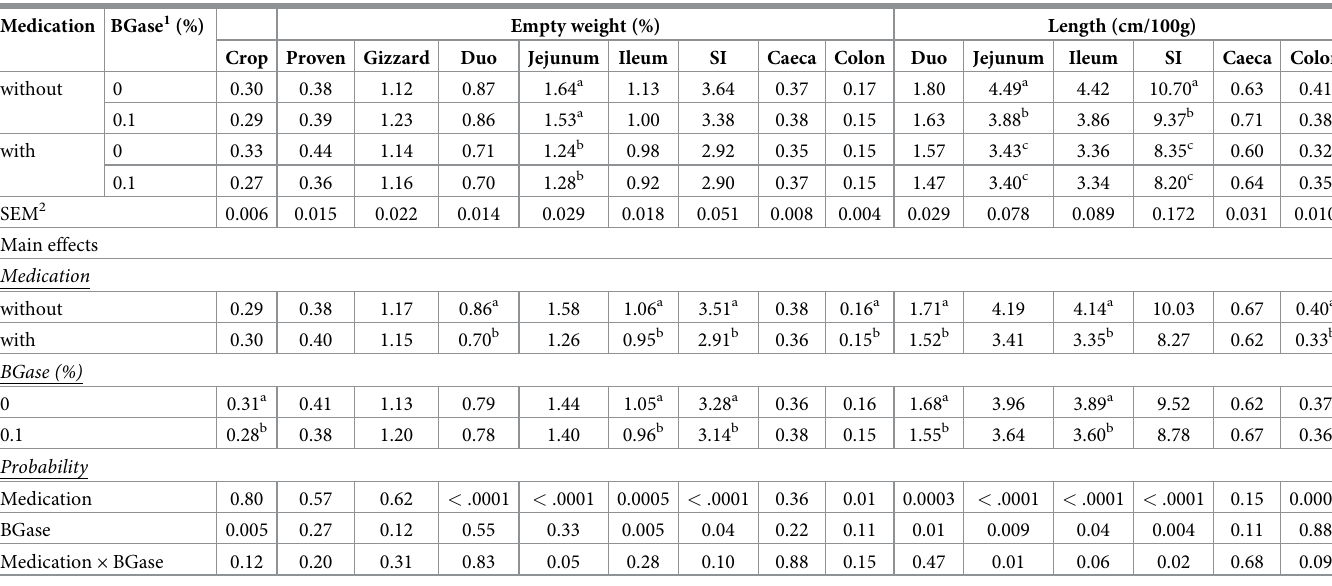
Table 17. Effects of diet medication and β -glucanase on gastro-intestinal tissue weights and lengths (proportional to body weight) of broiler chickens at day 33 (Experiment 2).